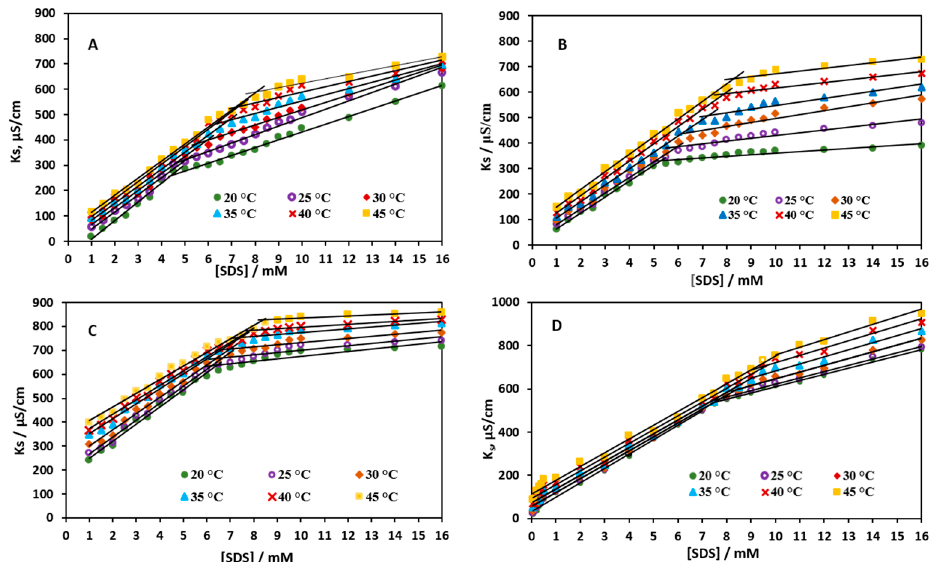
Figure 3. ( A ) The variation of electrical conductivity of SDS in an aqueous solution of 0.01 M L -Tryptophan with the concentration at different temperatures. ( B ) The variation of electrical conductivity of SDS in an aqueous solution of 0.01 M L -Histidine with the concentration at different temperatures. ( C ) The variation of electrical conductivity of SDS in an aqueous solution of 0.01 M DL -Glutamic acid with the concentration at different temperatures. ( D ) The variation of electrical conductivity of SDS with the concentration in water at different temperatures [25].